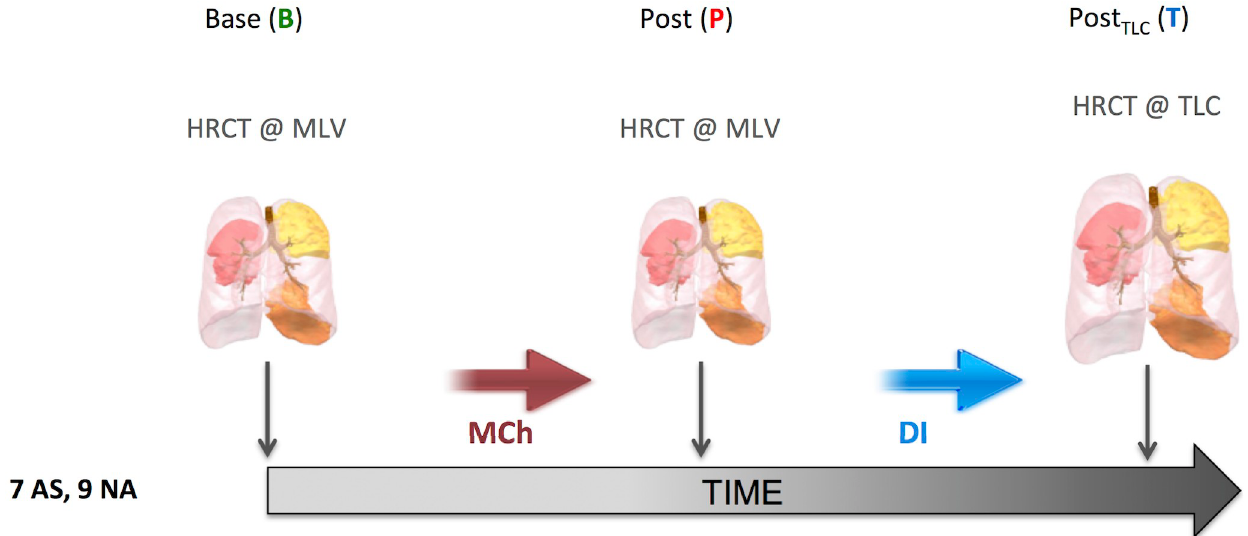
Fig 2. Study protocol. With the subjects in the supine position, HRCT images were acquired during a short breath hold (~12 s) under three consecutive conditions: 1 ) at baseline ( B ) and imaged at mean lung volume (MLV), where MLV was defined as the average lung volume during stable tidal breathing; 2) following five deep breaths of MCh at his/her previously determined PC20 dose and imaged at the subject’s spontaneous MLV ( P ); and 3 ) post MCh and imaged at total lung capacity ( T ). Colored regions of the lung correspond to 3 of the ~19 parenchyma segmental regions studied in each lung.